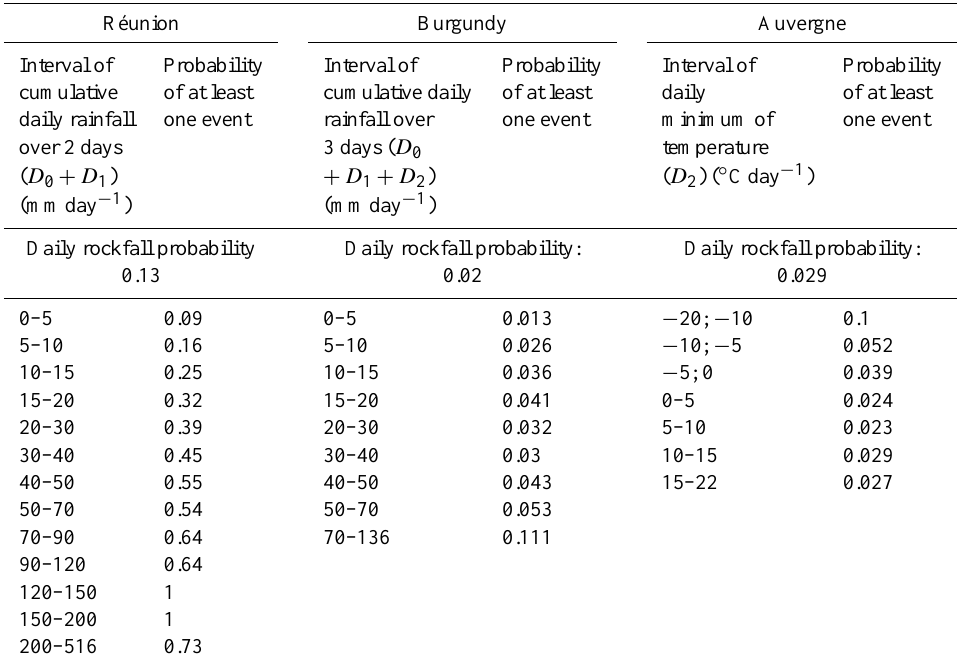
Table 6. Probability of having at least one event on a day falling within a given interval of daily rainfall (Réunion and Burgundy) and different intervals of daily minimum temperatures (Auvergne). Réunion Burgundy Auvergne Interval of Probability Interval of Probability Interval of Probability cumulative of at least cumulative daily of at least daily of at least daily rainfall one event rainfall over one event minimum of one event over 2 days 3 days ( D 0 temperature ( D 0 + D 1 ) + D 1 + D 2 ) ( D 2 ) ( ◦ Cday − 1 ) (mmday − 1 ) (mmday − 1 ) Daily rockfall probability Daily rockfall probability: Daily rockfall probability: 0.13 0.02 0.029 0.09 0–5 0.013 − 20; − 10